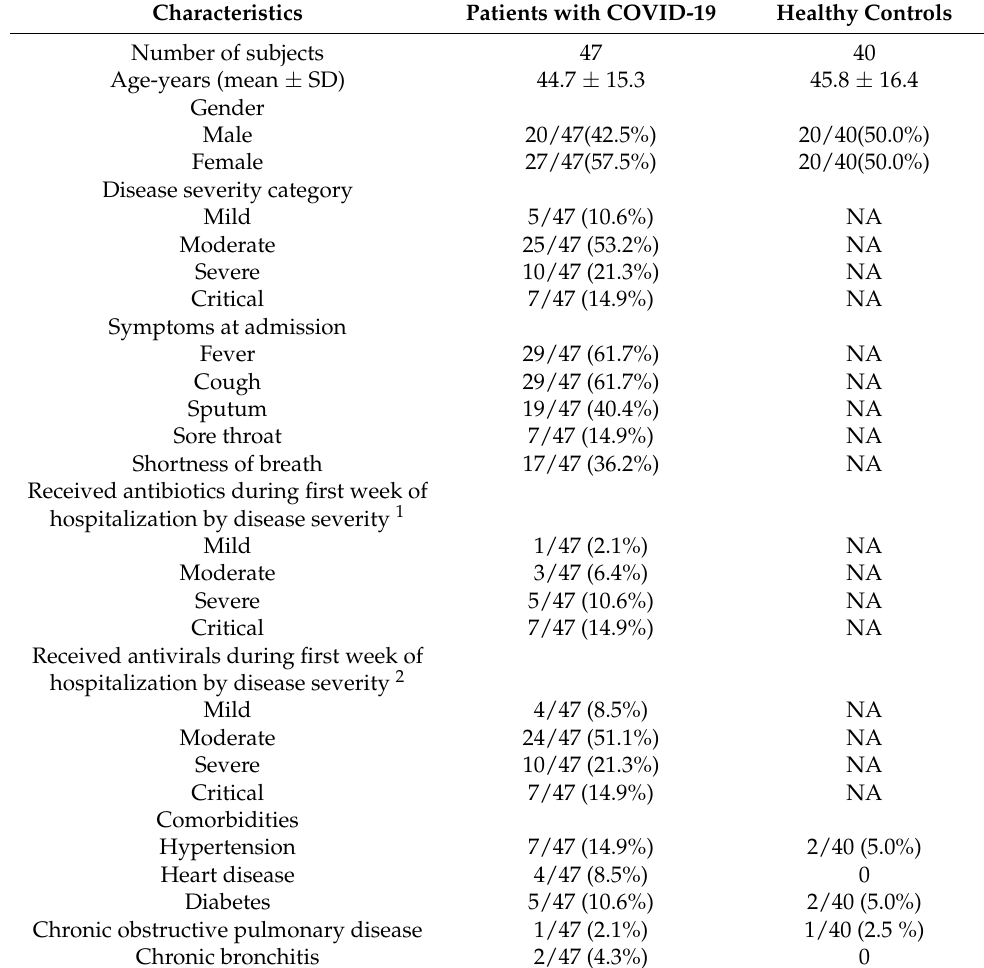
Table 1. Demographics and clinical characteristics of the participants.